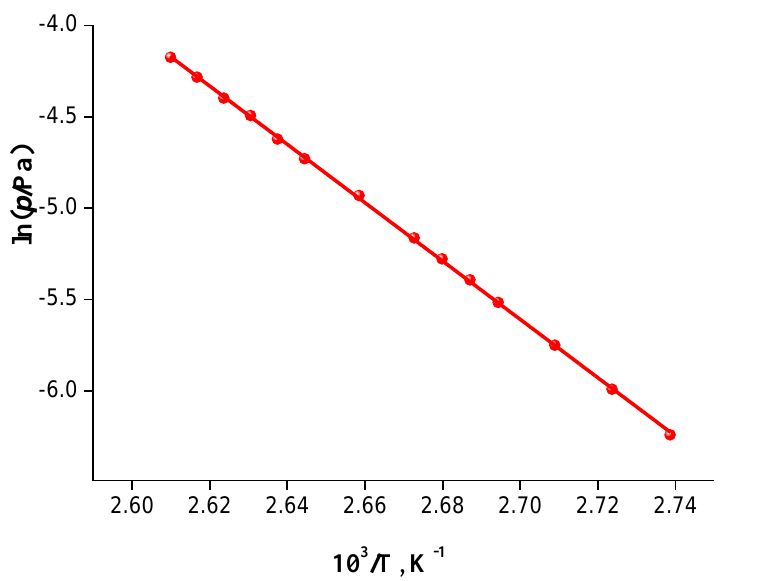
Figure 3. Plot of vapor pressure against reciprocal temperature of the compound studied.